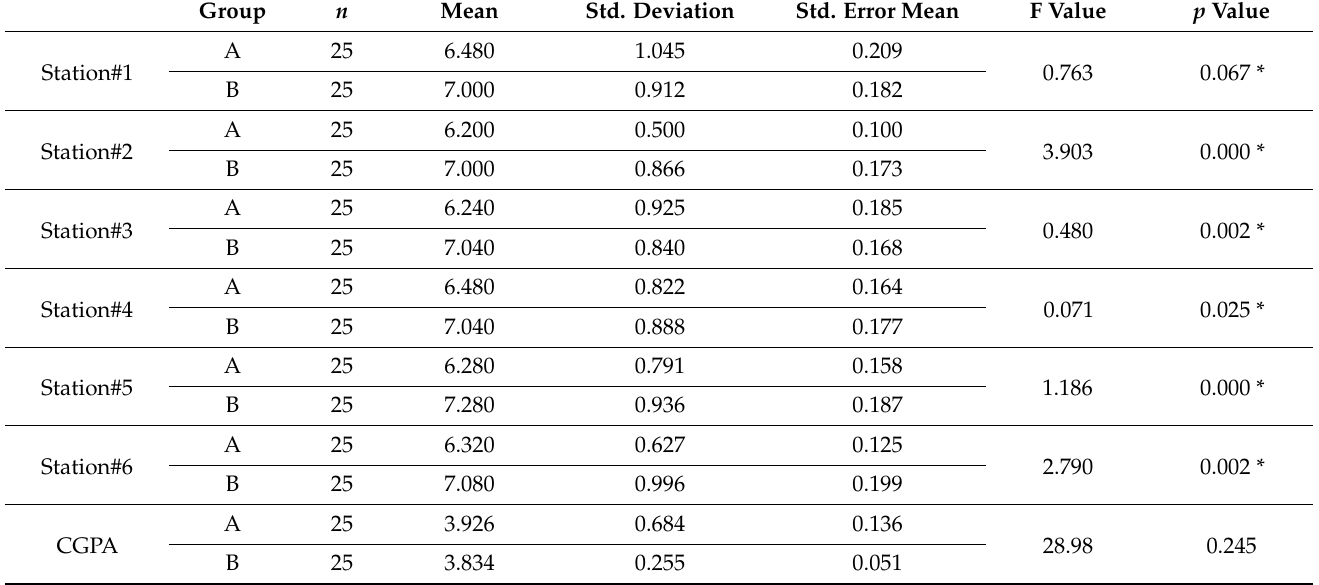
Table 1. Comparison of OSCE station scores with respect to Group A and Group